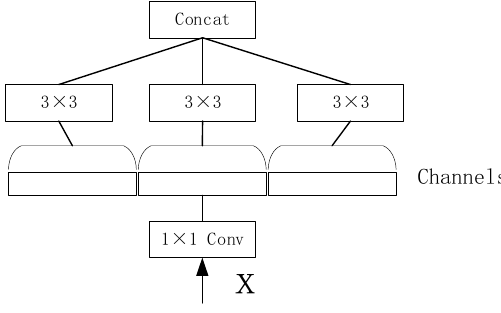
Figure 14. Basic structure of the Xception model.